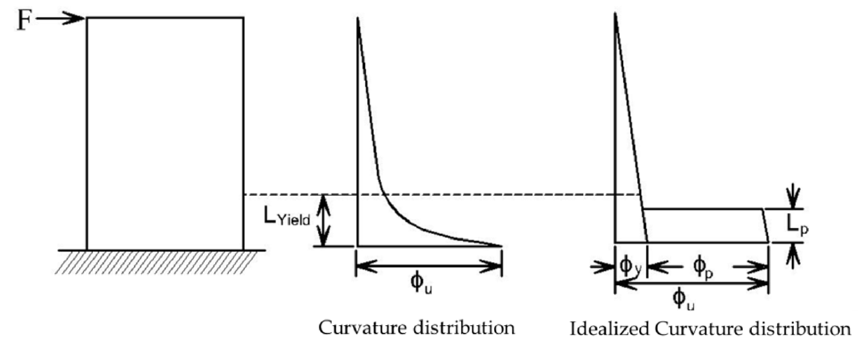
Figure 11. End ‐ of ‐ test picture of entire specimen